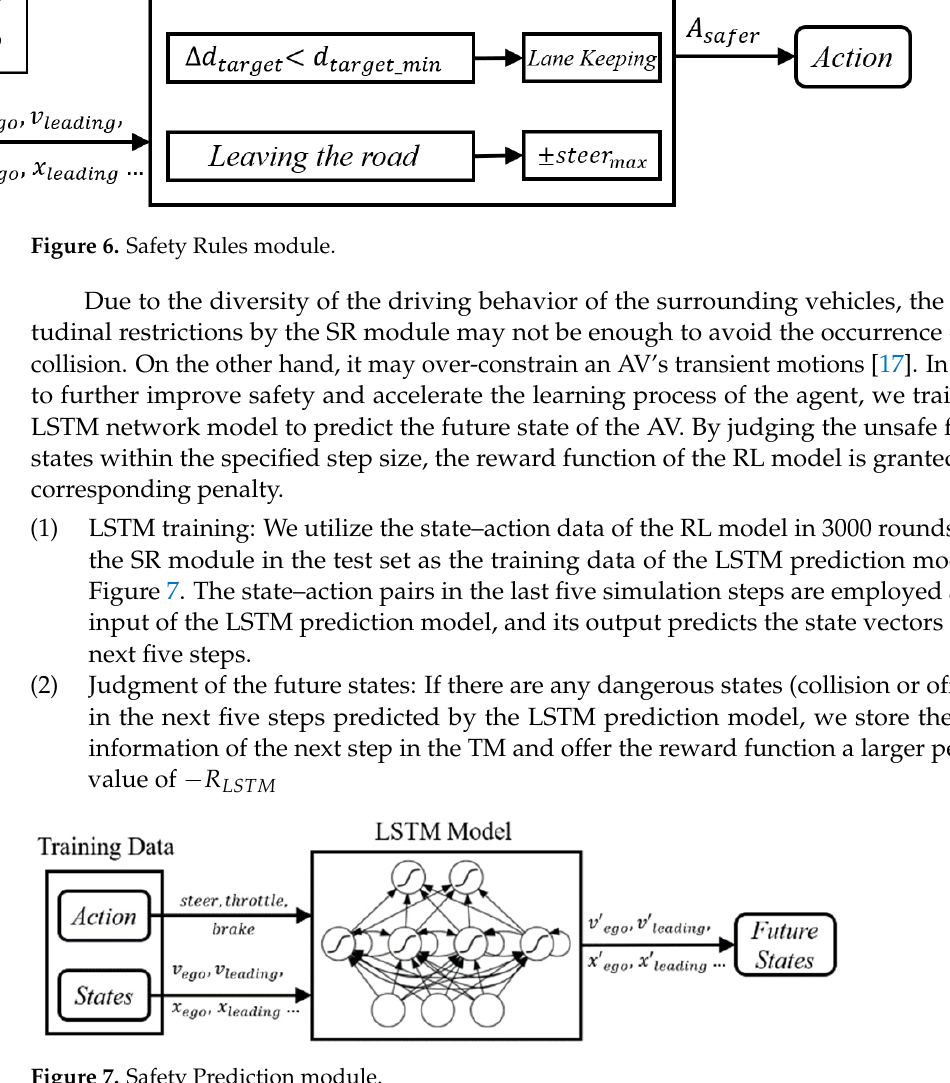
Figure 7. Safety Prediction